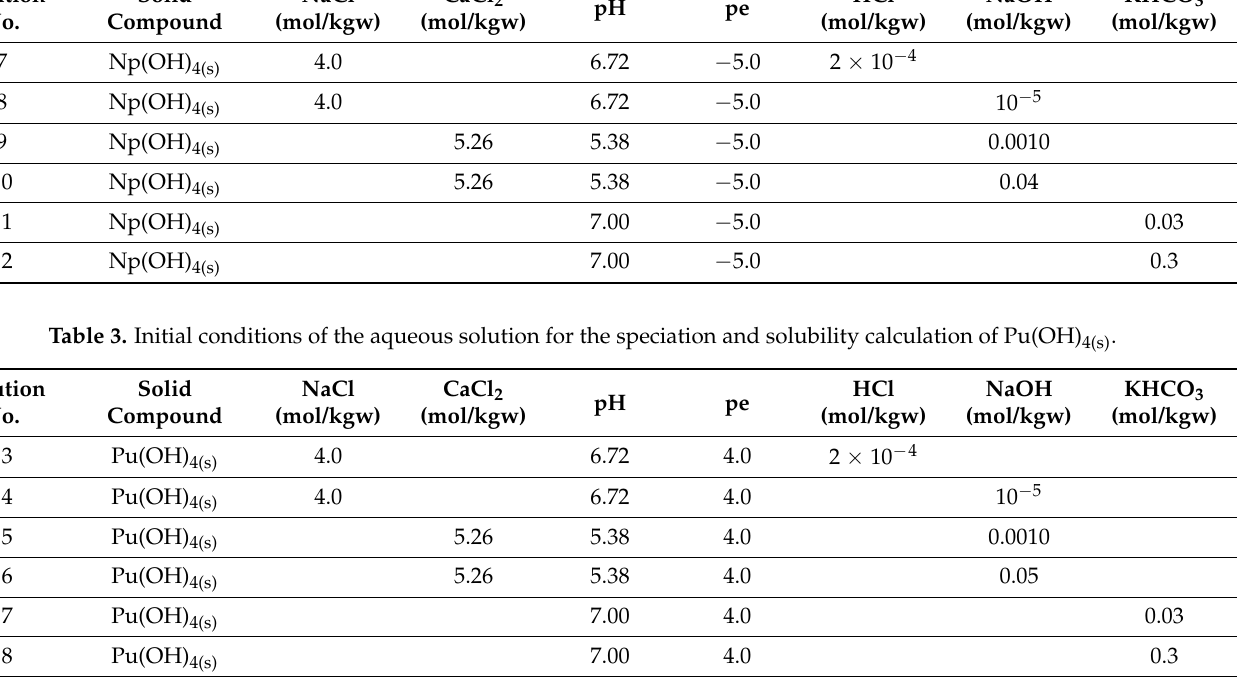
Table 2. Initial conditions of the aqueous solution for the speciation and solubility calculation of Np(OH) 4(s) . Solution No.